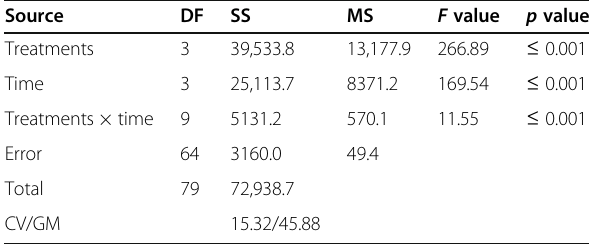
Table 2 Factorial analysis of variance of mortality of Bemisia